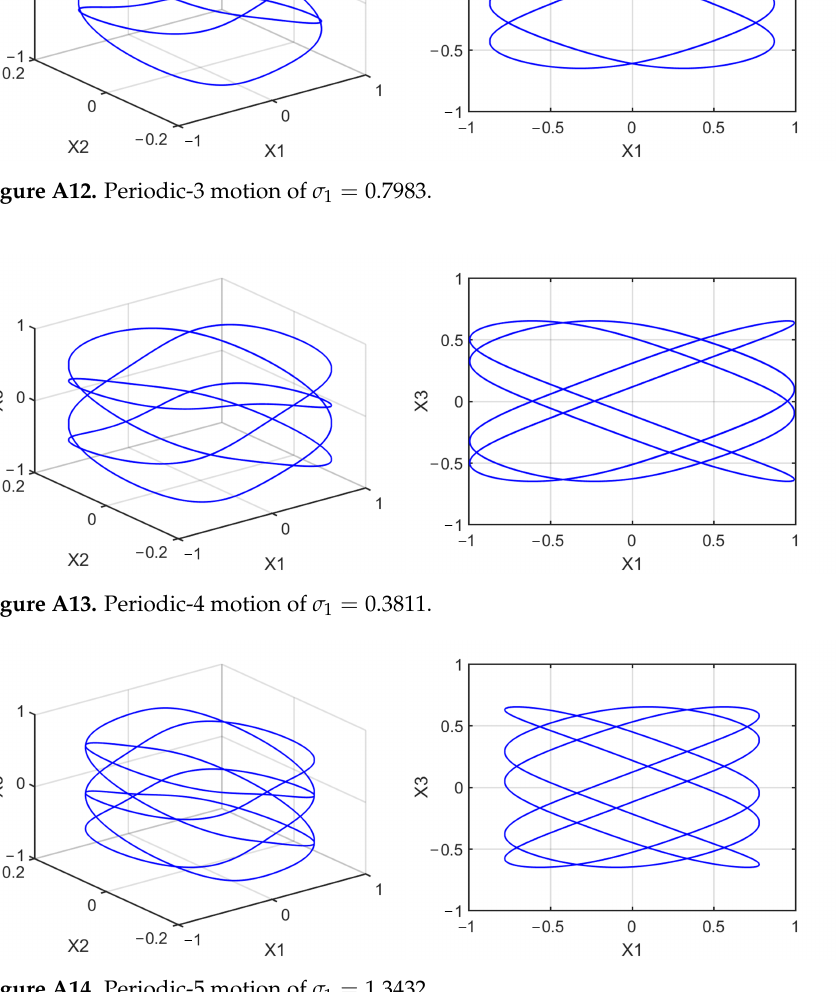
Figure A14. Periodic-5 motion of σ 1 =